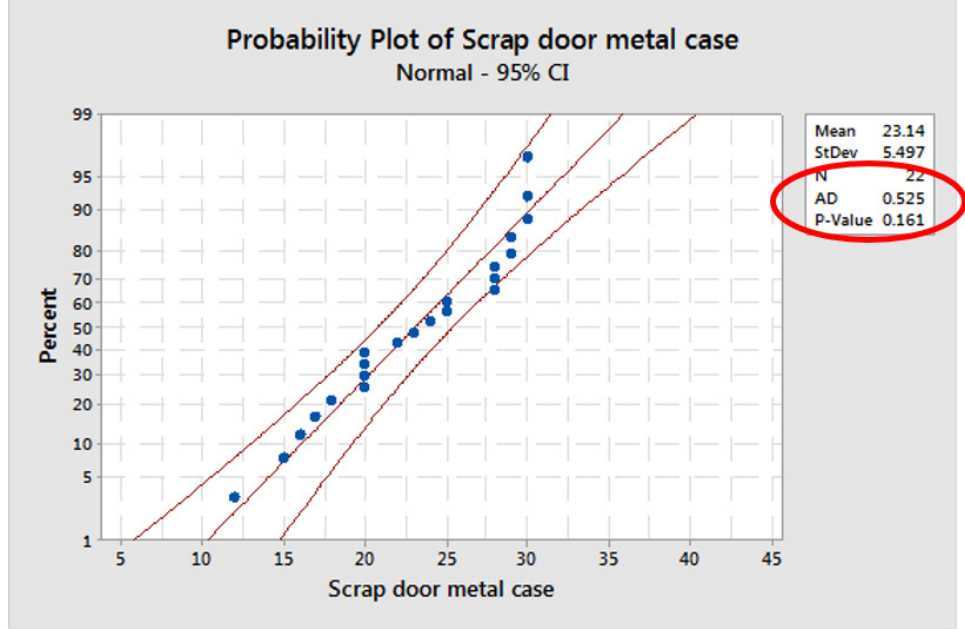
Figure 12. Probability diagram for the scrap.